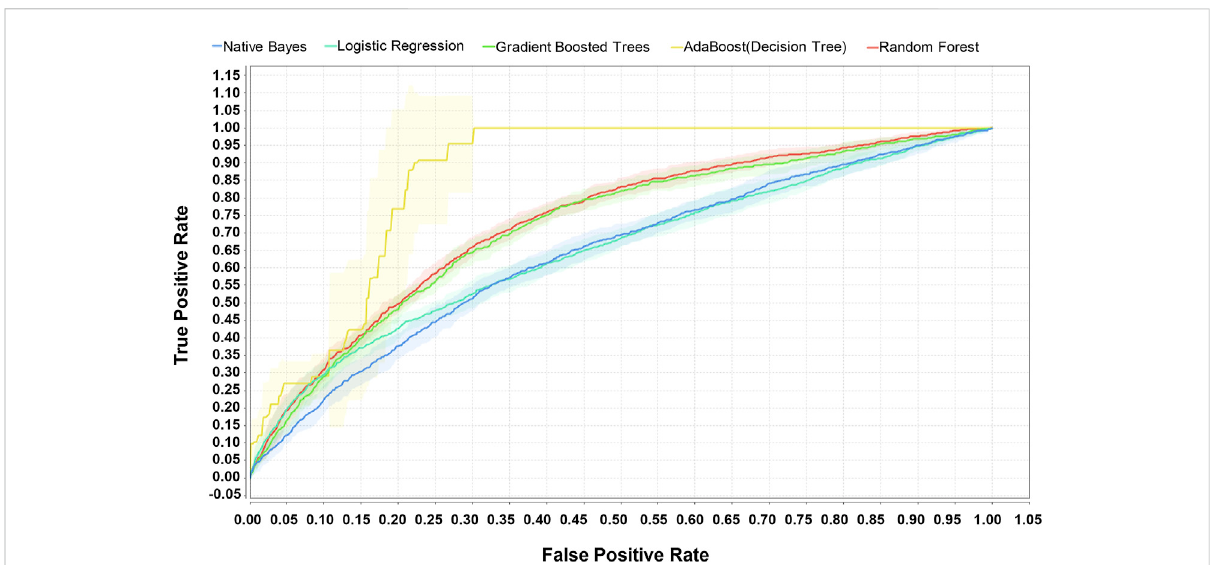
FIGURE 3 Comparison ofROCof fi vemachinelearningmethodsforpredictingsepsis-associatedARDSineICUtestset.TheAUCofthe fi vemodelsinthe eICUtestcohortare asfollows: NaiveBayes:0.644, Logistic Regression:0.653, Gradient BoostedTrees:0.736, AdaBoost (Decision Tree): 0.895, and Random Forest: